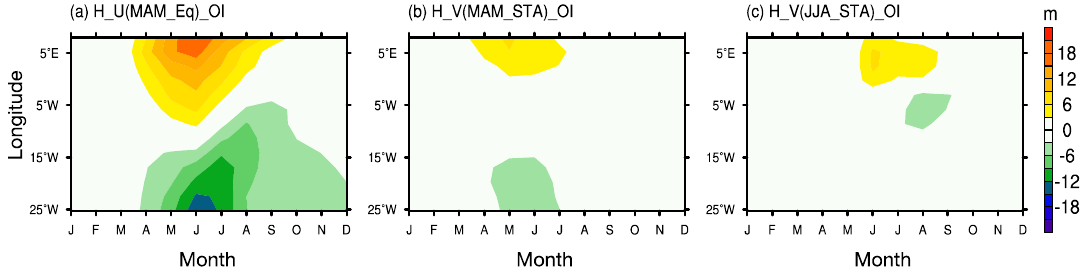
Figure 9. Longitude-month distributions of the bias at the 20 ◦ C isotherm depth (unit: m, shading) during 1979–2005 for H_U(MAM_Eq)_OI ( a ); H_V(MAM_STA)_OI ( b ); and H_V(JJA_STA)_OI ( c ).